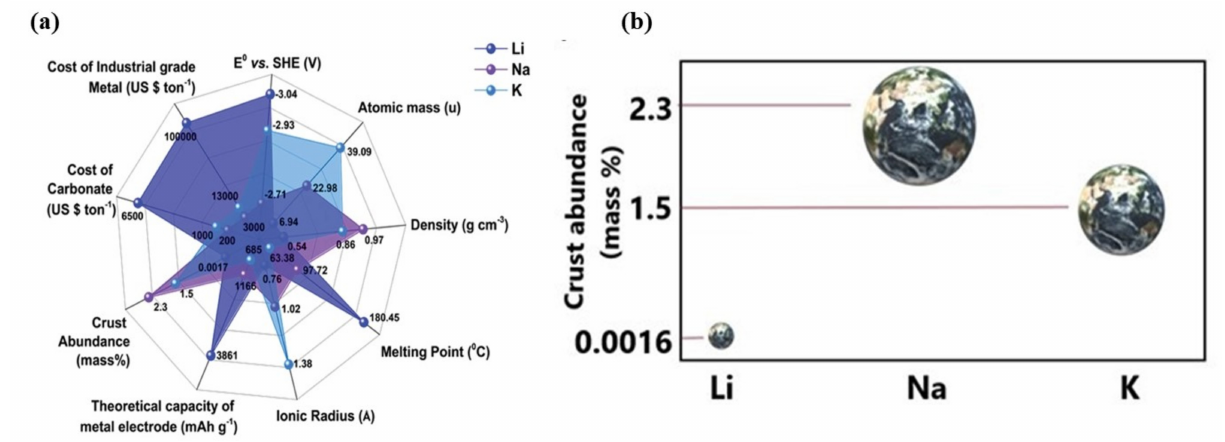
Figure 2. ( a ) Properties of alkali metals (adapted with permission from [51]. Adv Energy Mat., 2020). ( b ) Earth crust abundance comparison of Li, Na, and